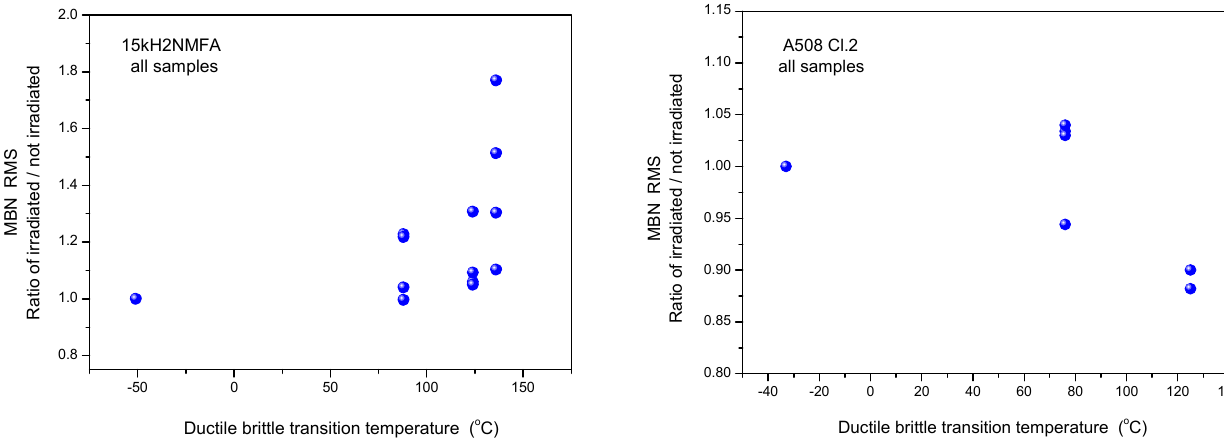
Figure 7. Normalized 3MA P3 parameter as function of transition temperature for all 15kH2NMFA and A508Cl.2 samples.